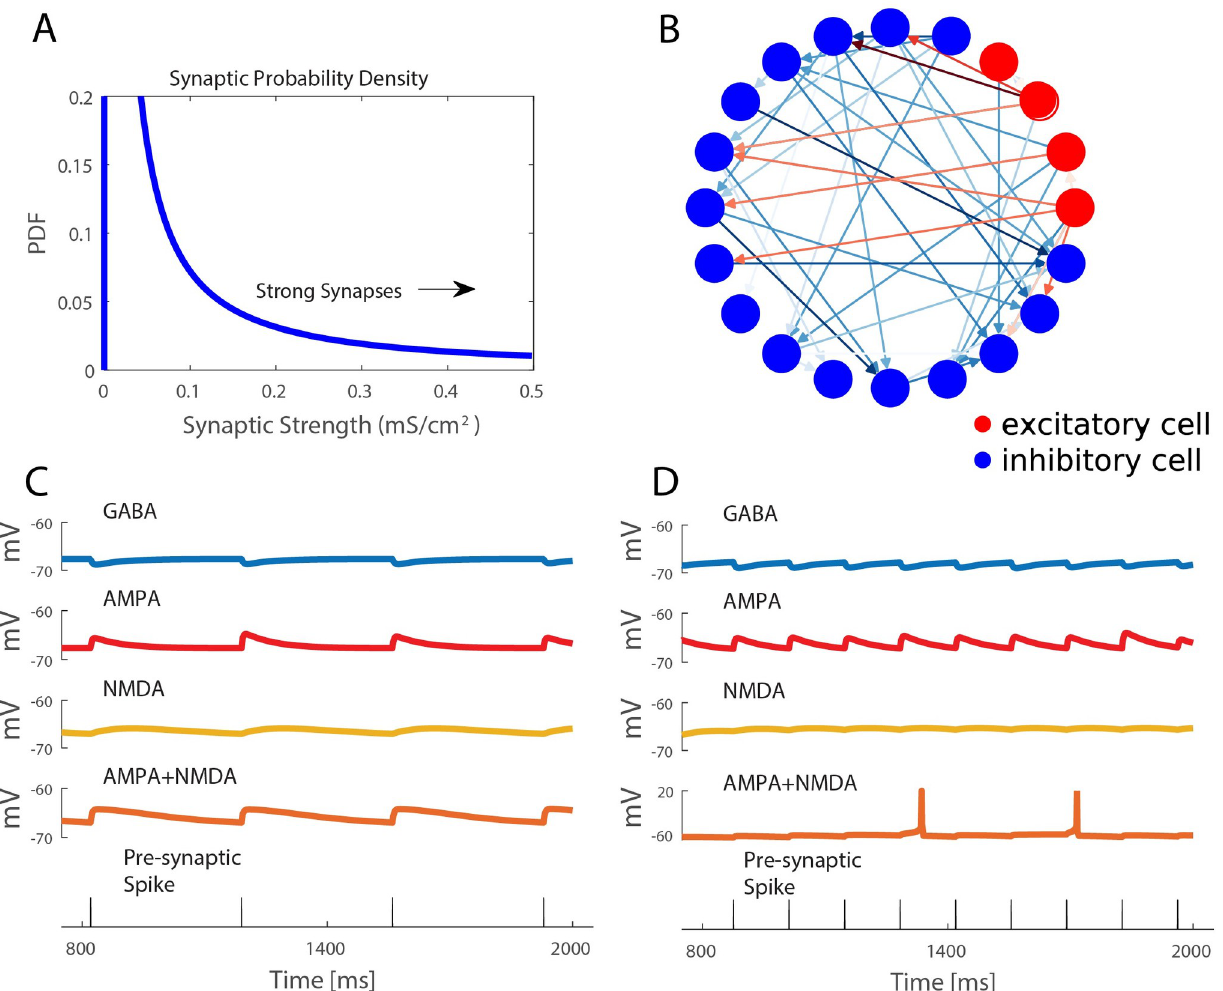
Fig 8. Network structure is populated by lognormal distributed random connection strengths. A). Synaptic strengths in model networks varied according to a lognormal distribution with a minority of connections being mediated by strong synaptic strengths, while weak synaptic strengths constitute majority of connections B) Simulated network consists of 200 inhibitory and 800 excitatory cells connected randomly with 10% probability. Connection color reflects the log of synaptic strength. C, D) Postsynaptic potential time courses in response to synaptic currents mediated by different receptors. Excitatory currents are modeled with both AMPA and NMDA mediated currents. Bottom panel shows timing of presynaptic spikes, for simplicity both inhibitory and excitatory presynaptic neurons are shown with the same spike times.